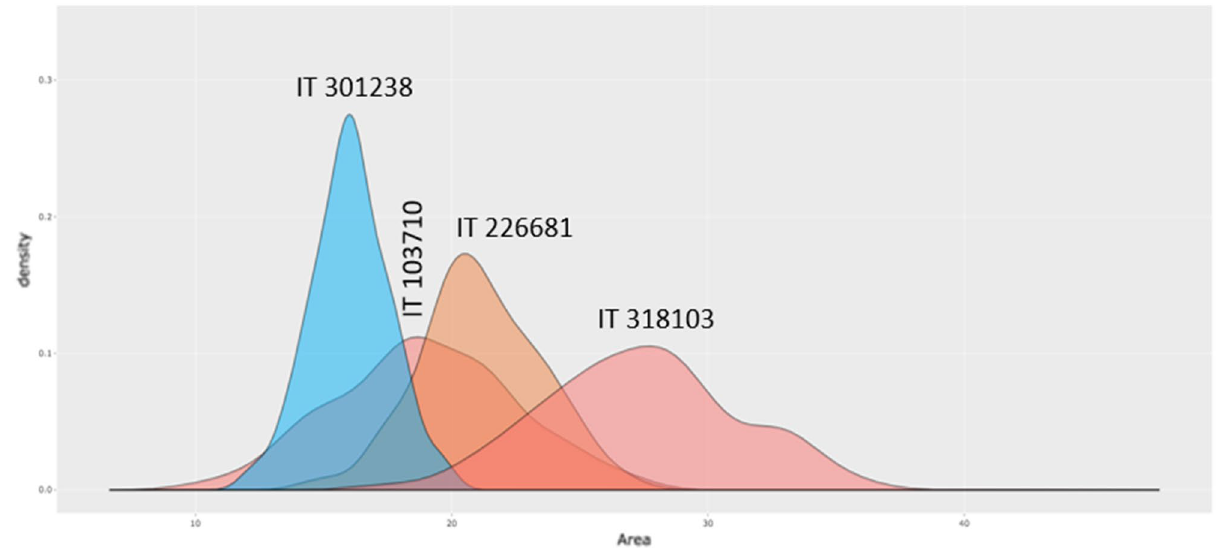
Figure 3. Feature (Area) density plot of four line (IT 301243, IT 103710, IT 226681 and IT